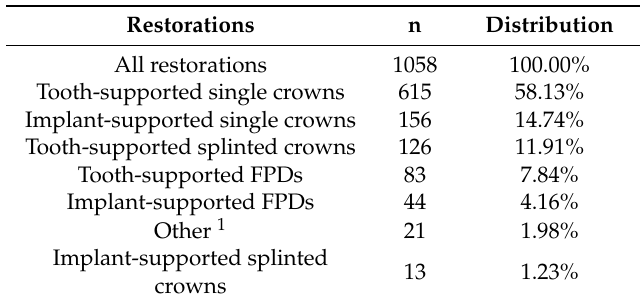
Table 3. Detailed listing of the evaluable crowns and fixed partial dentures (FPDs).